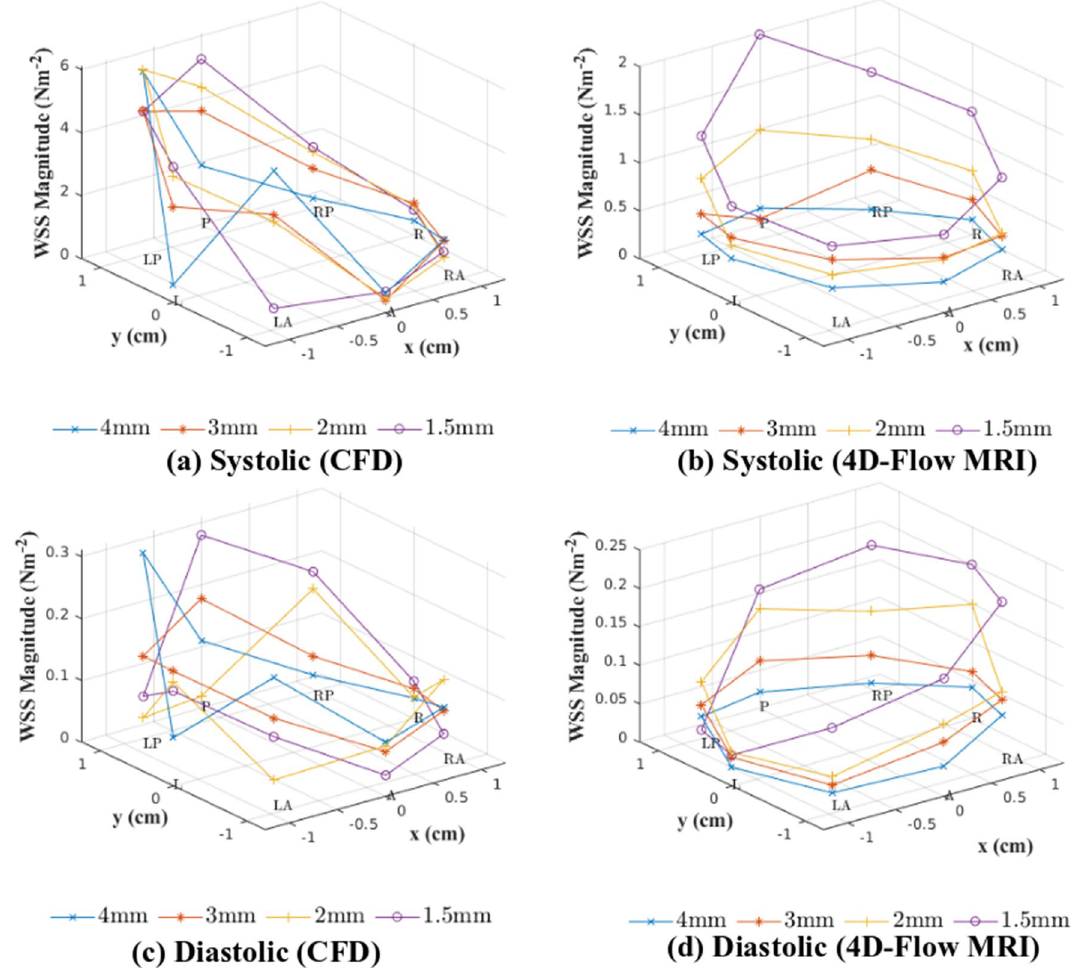
Figure 8. Wall shear stress magnitude values at eight locations on the thoracic aorta wall at a plane in the mid ascending aorta determined through 4D-Flow MRI and CFD for all four resolutions over the systolic ( a , b ) and diastolic ( c , d ) phase of the cardiac cycle. R right, RP right-posterior, P posterior, LP left-posterior, L left, LA left- anterior, A anterior, RA